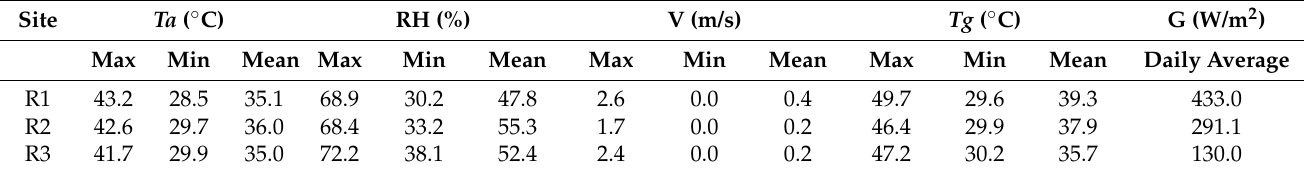
Table 5. Meteorological parameters of three sites during the measurement period in